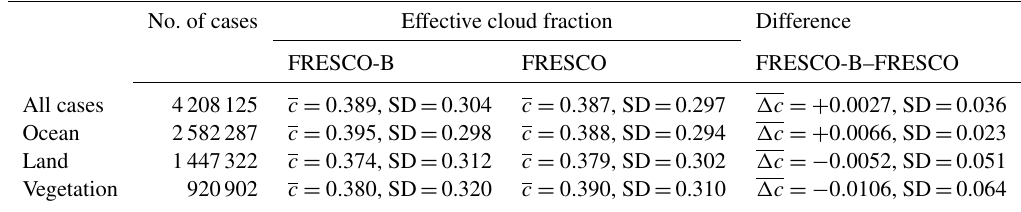
Table 2. Mean effective cloud fractions and standard deviations for FRESCO-B and FRESCO, as well as the mean difference between them, for GOME-2B measurements in July 2014 over different surfaces. The vegetation category is a subpart of the land